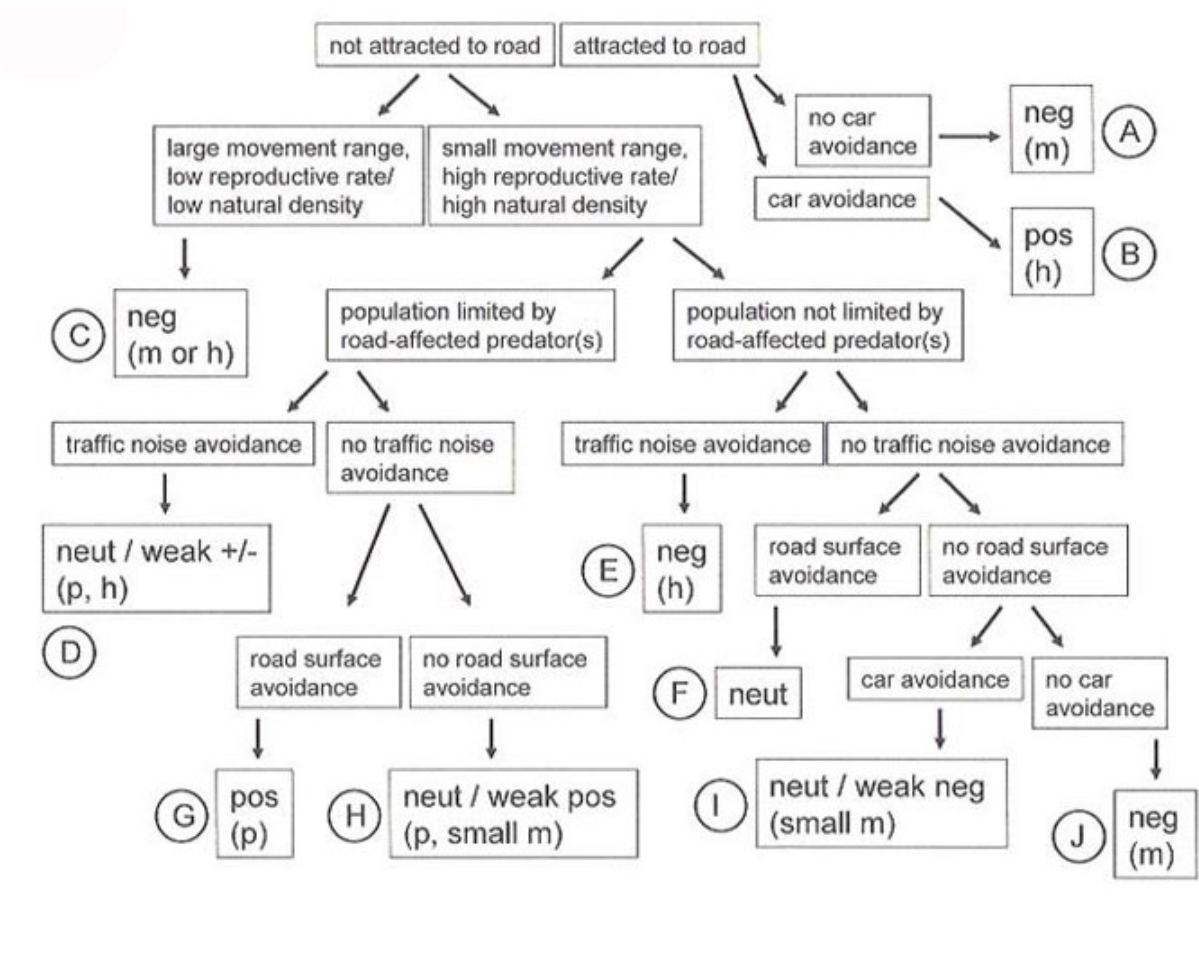
Fig. 2. Summary of the factors affecting the size and direction of road effects on animal abundance, with 10 possible cases. Each case is defined by all the conditions leading to it through the arrows above. “neg,” “pos,” and “neut” refer to negative, positive, and neutral effects of roads on abundance (respectively). “m,” “h,” and “p” refer to the mechanisms creating road effects on the populations: mortality, habitat loss or increase, and predation release (respectively). Mortality and habitat loss are negative effects, and habitat increase and predation release are positive effects of roads on animal abundance. Examples of species in each case are: some turtles and snakes (A), vultures (B), large mammals, some mid-sized mammals, and some large birds (C), some small birds (D and E), small mammals (F, G, H, I), and amphibians